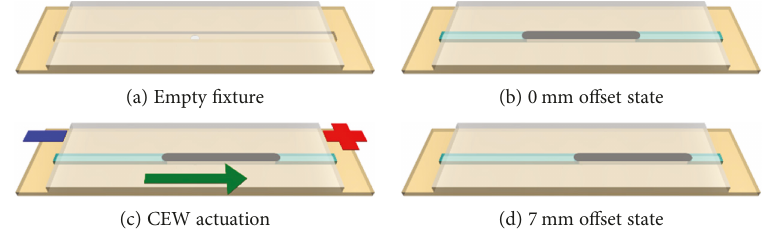
Figure 6: Liquid-metal actuation process: (a) empty fi xture; (b) Galinstan slug resting in the 0mm o ff set state (center) submerged in NaOH (cyan); (c) the NaOH at the left of the channel is grounded (blue negative sign) and a 60 Hz, 1 V applied to the NaOH at the right end of the channel, inducing CEW and actuating the Galinstan slug rightward; (d) the Galinstan slug resting in an X -mm-o ff set state (7 mm o ff set here) does not need an applied potential to remain in position. The entire process can be reversed by reversing the locations in which the AC signal and ground are